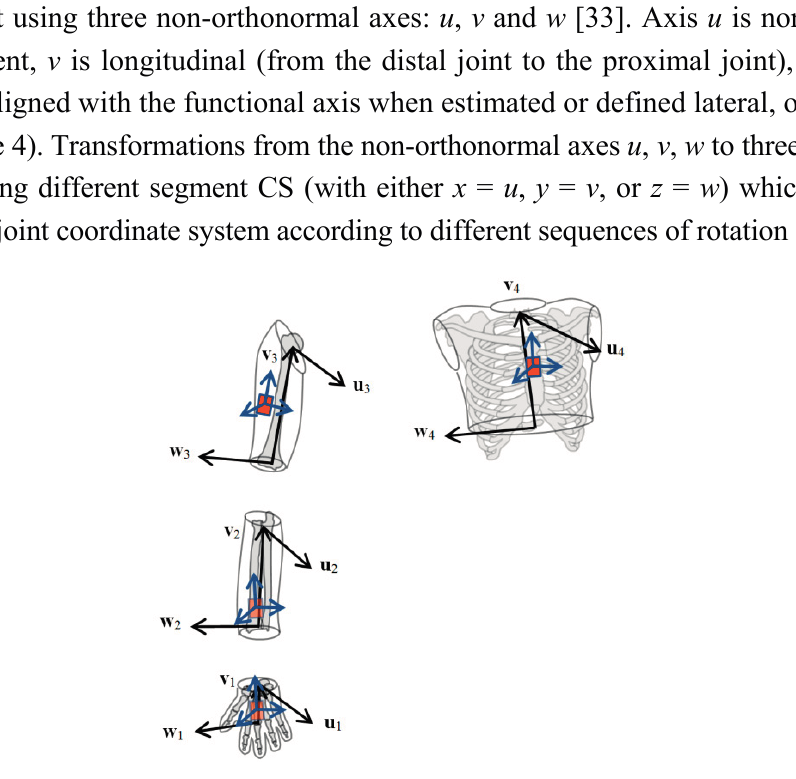
Figure 4. The non-orthonormal segment representation ( u , v , w ) used for the hand, forearm, upper arm, and thorax